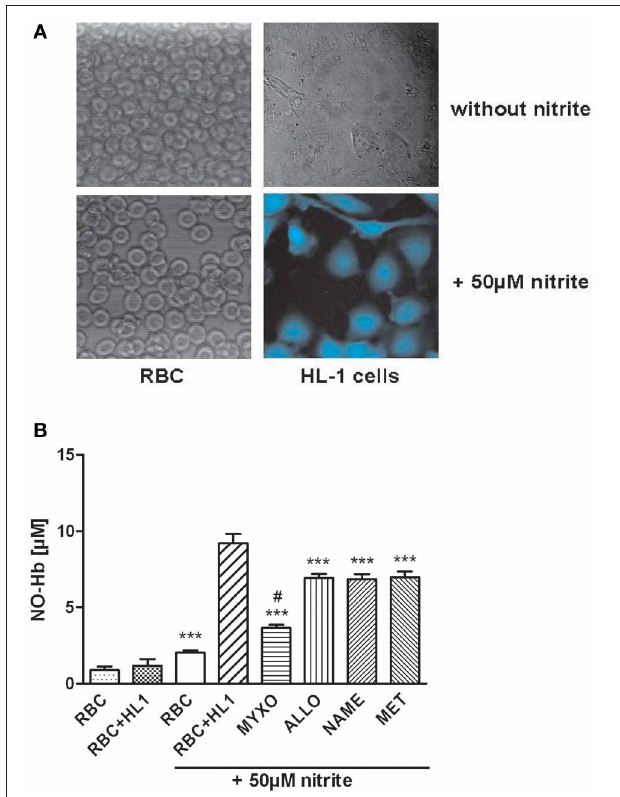
FIGURE 2 | (A) Analysis of free NO using a NO-specific dye and confocal microscopy. HL-1 cells or RBC were loaded with 10 µ M DAF-FM and incubated for about 30min at 37 ◦ C. Afterwards, 50 µ M of NaNO 2 were added and cells were incubated for another 30min at 37 ◦ C under anaerobic conditions. Free NO could only be detected in HL-1 cells but not in RBC. (B) Influence of various inhibitors on NO-Hb signals of RBC in co-culture with HL-1 cells determined by EPR analysis. Myxothiazol, an inhibitor of complex III of the respiratory chain, reduced NO-signal by 60%, while all inhibitors reduced NO-Hb levels by approx. 25%. ∗∗∗ p < 0 . 001, compared to HL-1 cells incubated with 50 µ M nitrite. # p < 0 . 05, compared to RBC incubated with 50 µ M